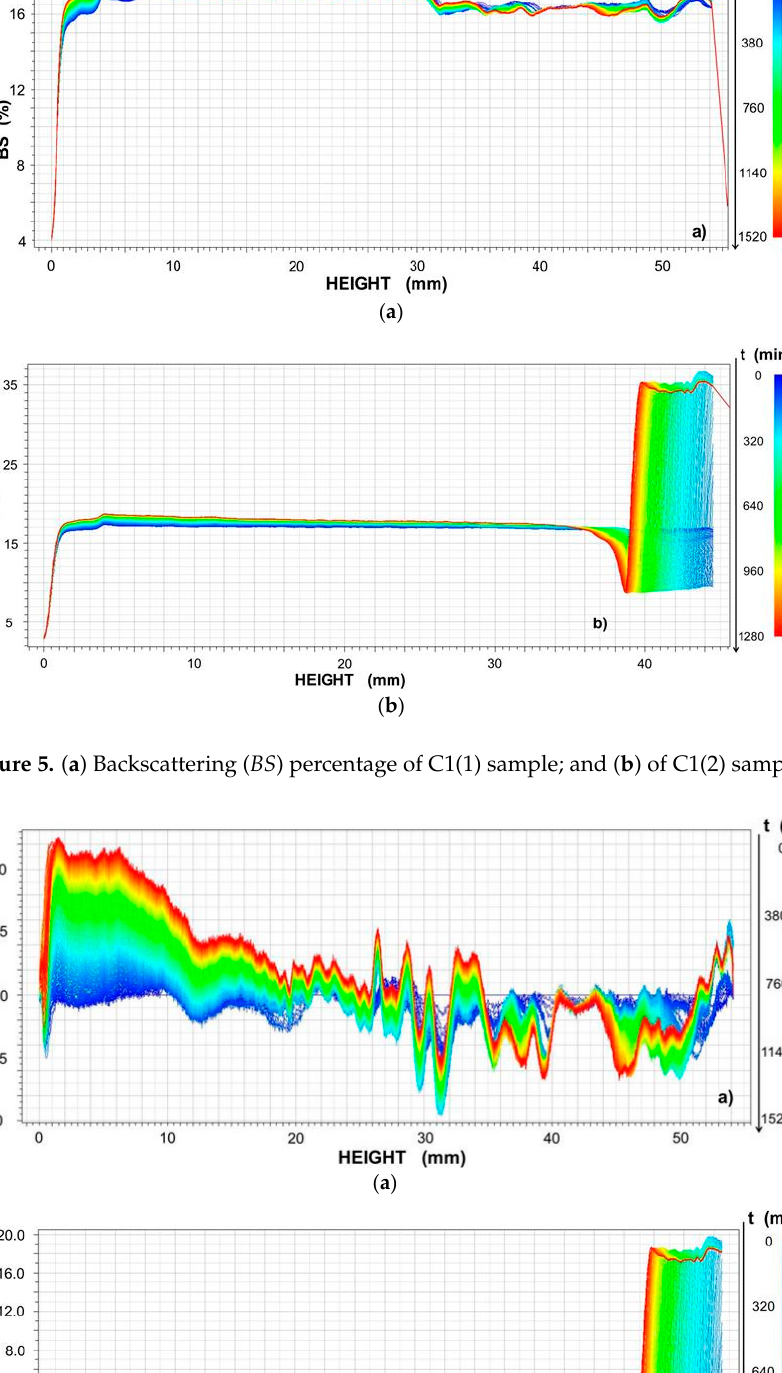
Figure 6. ( a ) ∆ BS of C1(1) sample; and ( b ) ∆ BS of C1(2) sample.